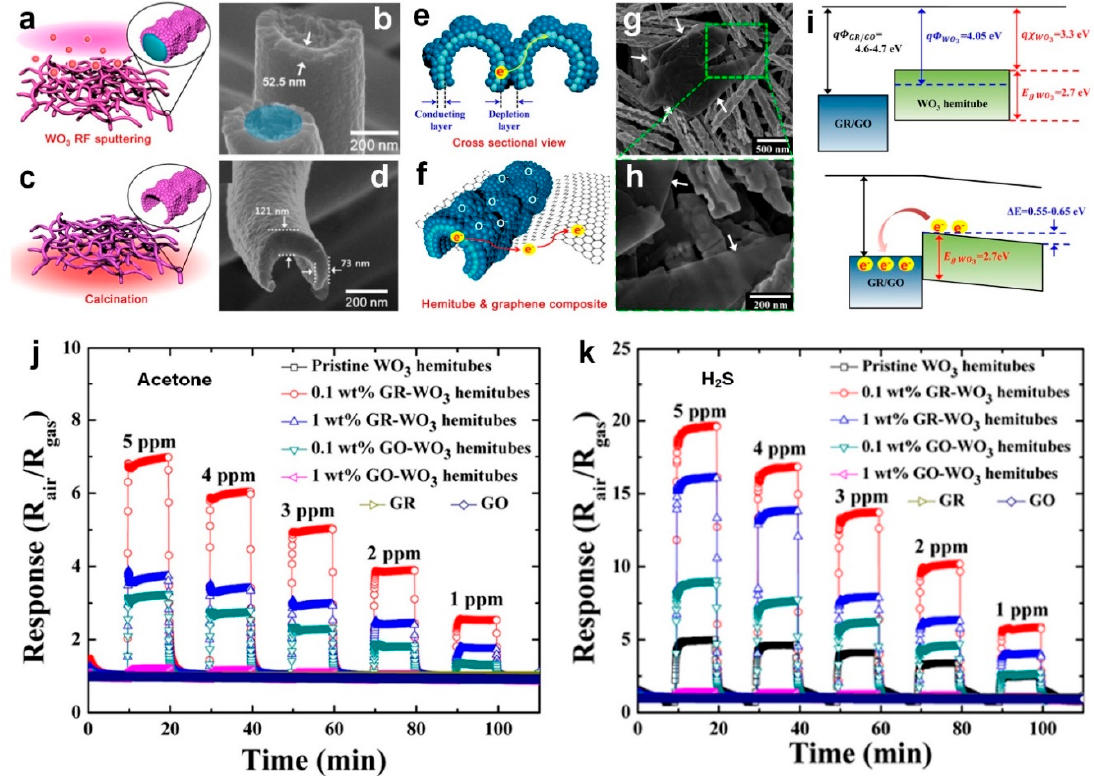
Figure 4. Schematic illustration and SEM images of fabricated WO 3 hemitubes ( a , b ) before and ( c , d ) after calcination at 500 °C for 1 h. [4,5] ( e ) Homojunction between WO 3 hemitubes and ( f ) a graphene-based material and a WO 3 hemitube. SEM image of GR-WO 3 hemitube composite at ( g ) low and ( h ) high magnification. Band structure model for GR/GO and WO 3 hemitubes relative to the vacuum level. Sensing responses of fabricated WO 3 hemitubes upon exposure to ( j ) acetone and ( k ) H 2 S with different concentrations from 1 to 5 ppm at 300 ℃ . [4] Reproduced with permission [4], Copyright 2014,